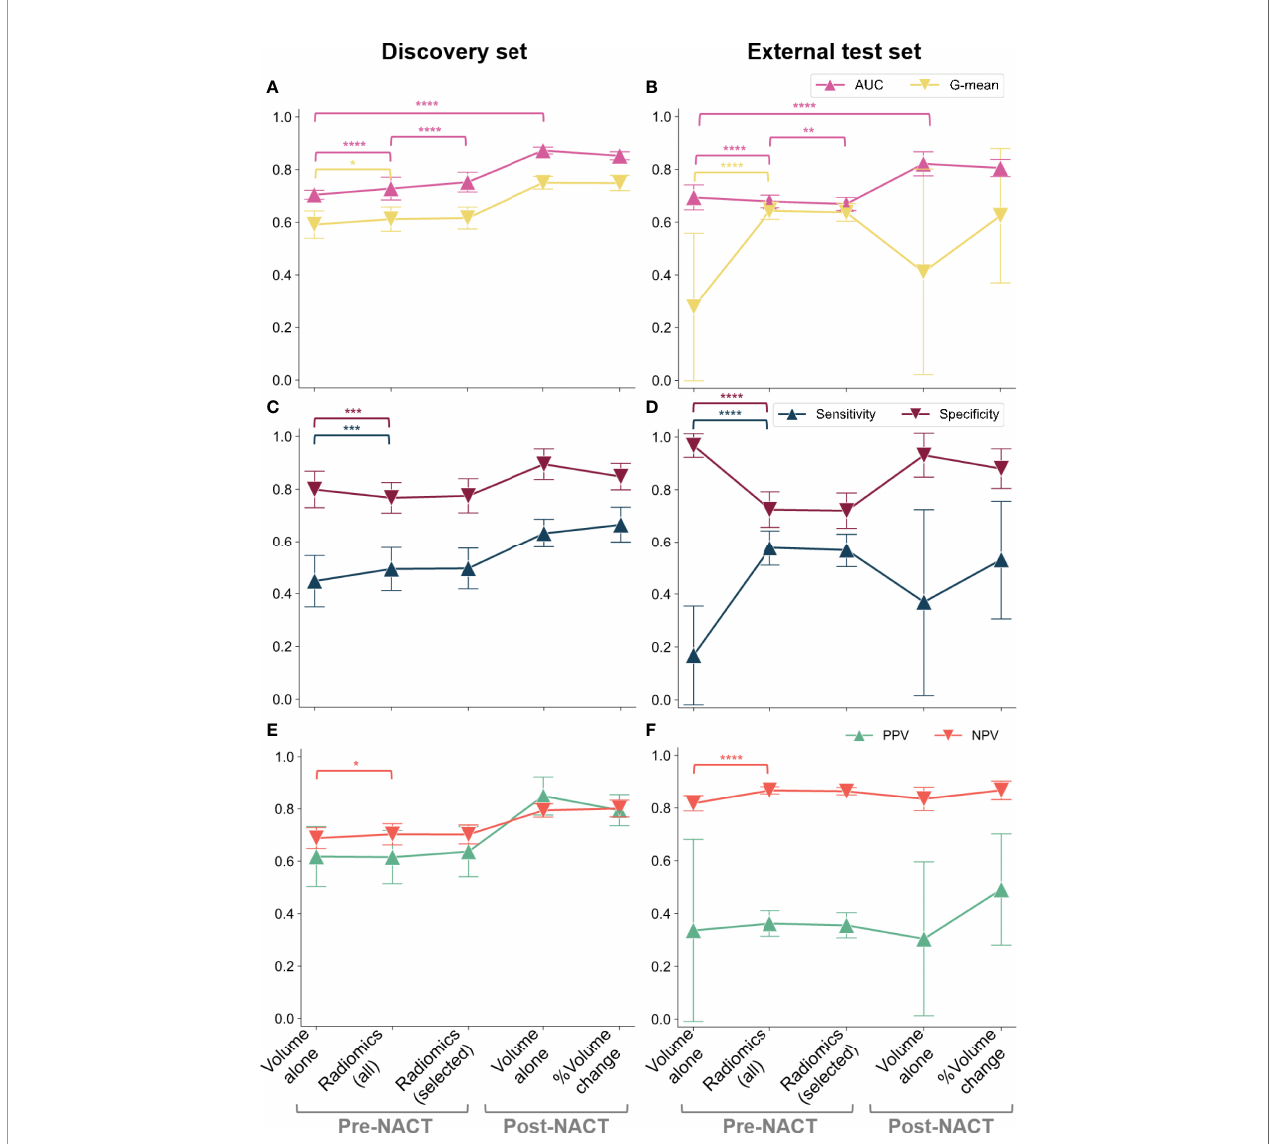
FIGURE 4 | CRS classi fi cation results in terms of AUC and G-mean ( fi rst row), along with sensitivity and speci fi city (second row) and PPV and NPV (third row): (A, C, E) discovery cohort; (B, D, F) external test set. We considered the pre-NACT volumetric model and radiomic models fi tted on either all the preprocessed features (robust and non-redundant) or only on the most frequently selected (i.e., relevant) features along with omental tumor volume. The variability across 100 repetitions was considered. The dots and error bars denote the average value and the standard deviation, respectively. Brackets denote statistical signi fi cance of particular interest using a Wilcoxon rank-sum test. Notation: * p < 0.05, ** p < 0.01, *** p < 0.001, **** p ≪